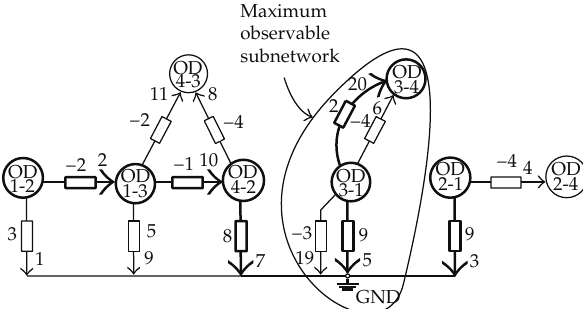
Figure 8: Nguyen-Dupuis case 2: associated network, maximum measured graph, and maximum observ- able